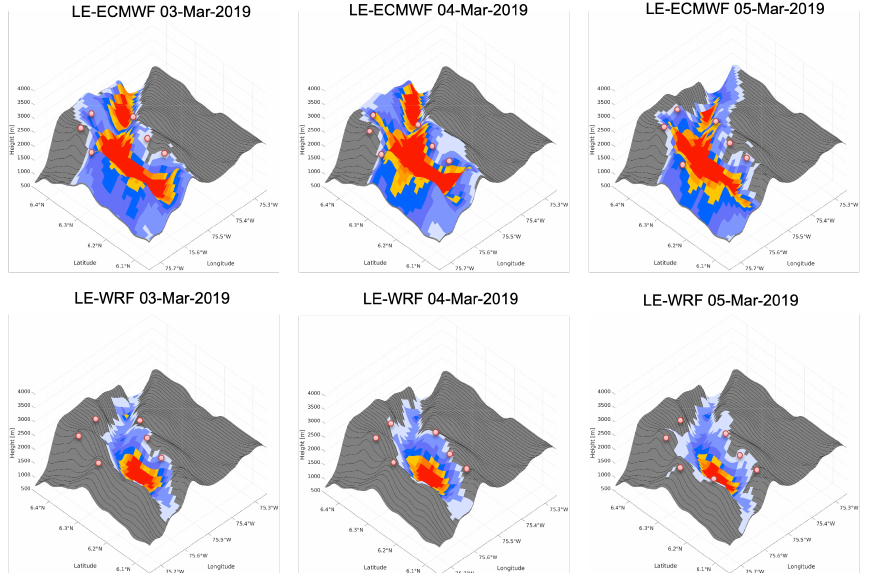
Figure A1. Different meteorology field input (ECMWF and WRF) the LOTOS-EUROS CTM simulat- ing particulate matter 2.5 for the contingency period of the 3, 4, and 5 of March 2019. The red dots are the station network’s location. There is a noticeable difference in the particulate matter concentration fields that, in one situation, respect the other and is trapped by the valley